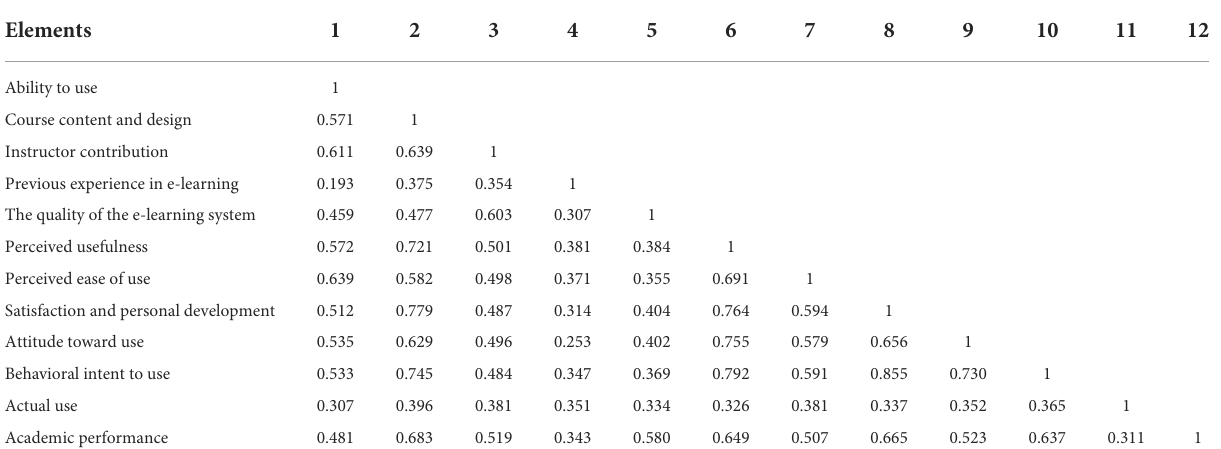
TABLE 6 The correlation matrix.